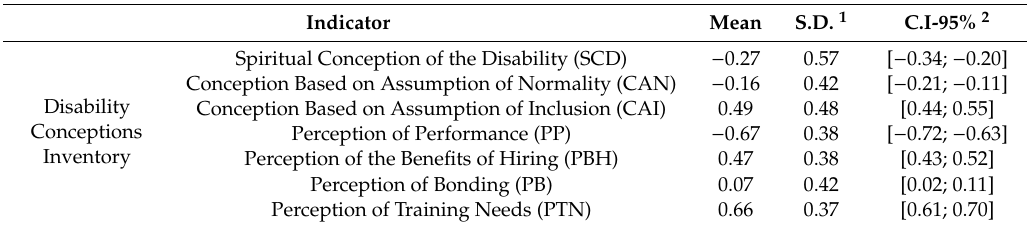
Table 3. Description of the